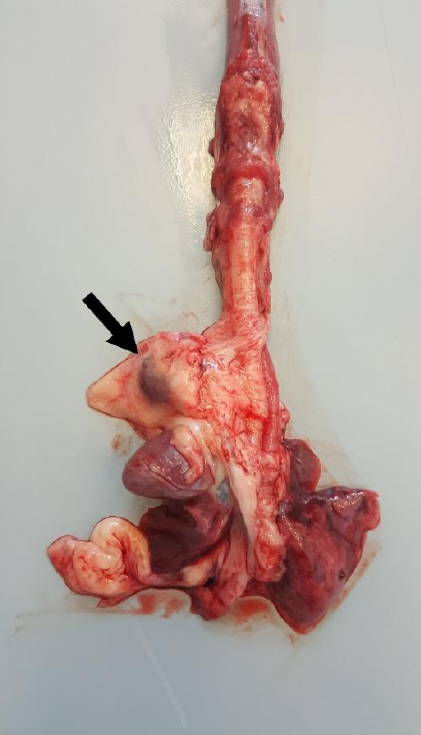
Figure 7. Thoracic organs. In the cranial mediastinum, surrounded by a moderate amount of adipose tissue, a severely enlarged lymph node (arrow) was detected.